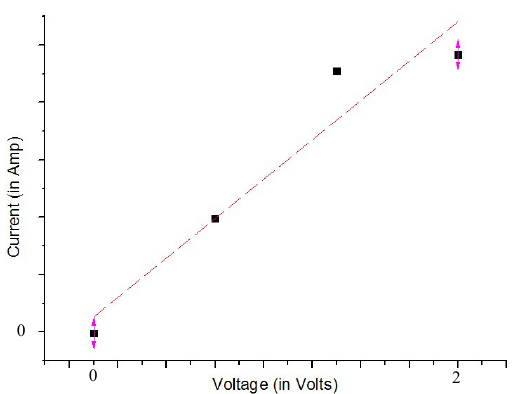
Figure 3. Current–voltage characteristic and their linear fitting between 0 V and 2 V.